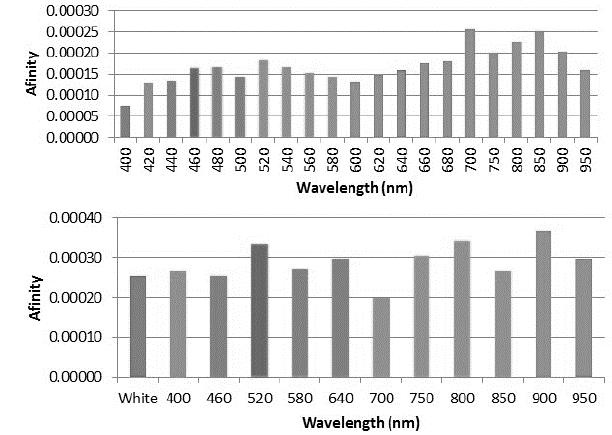
Figure 11. Variation in Affinity with Wavelength.